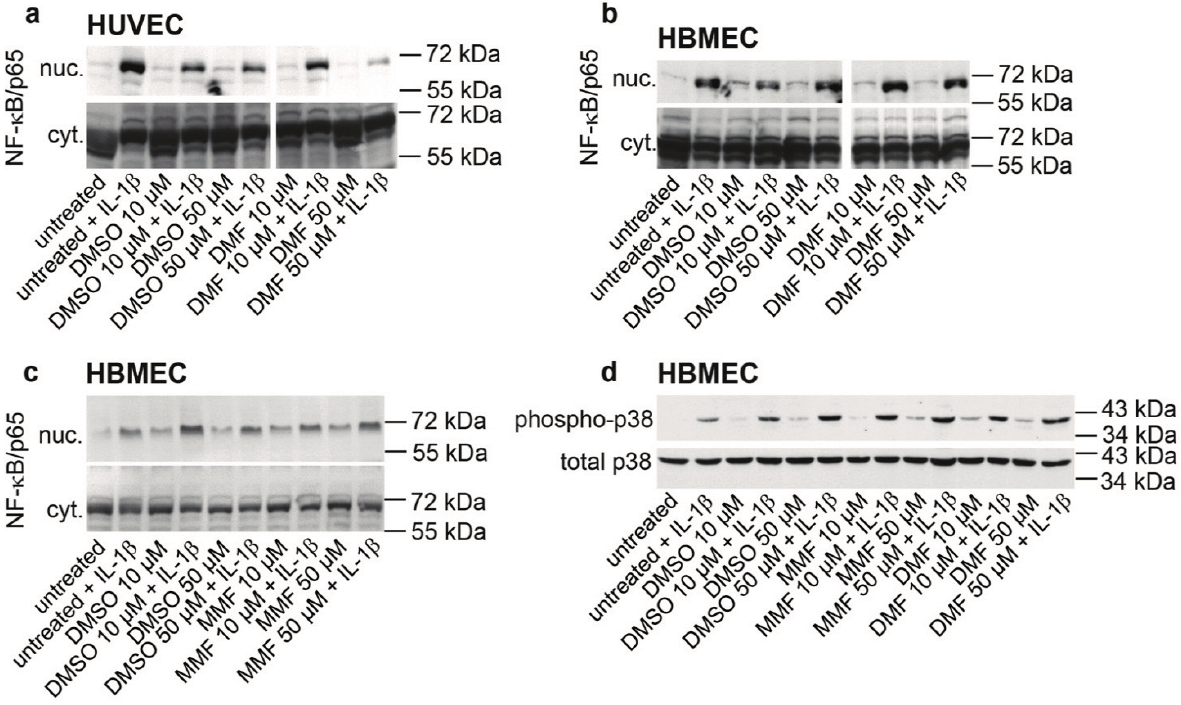
Figure 1. FAE do not modulate NF- κ B nuclear translocation or p38 MAPK activation